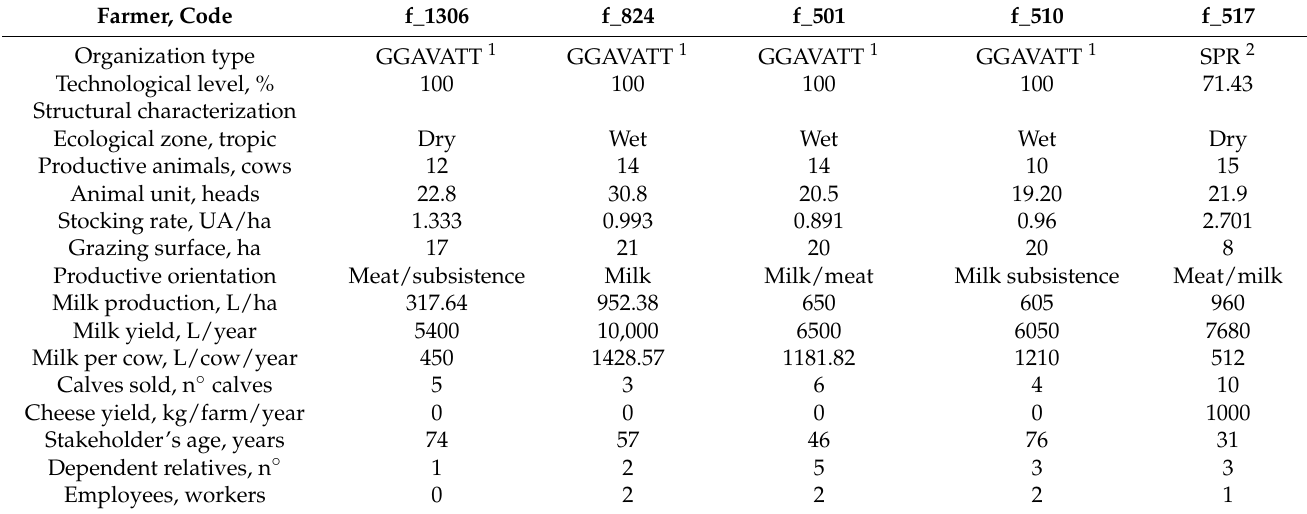
Table 4. Farmer’s benchmarking by organization type and technological